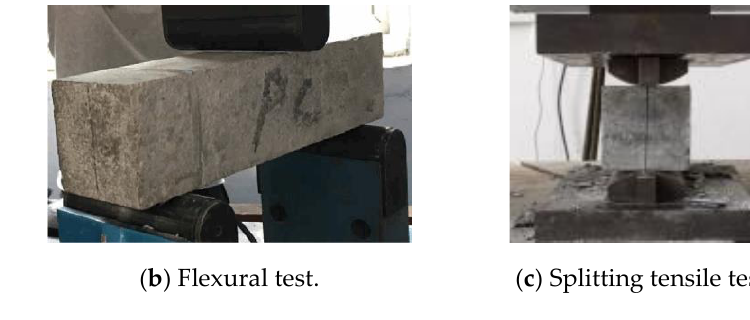
Figure 3. Experimental set-ups.